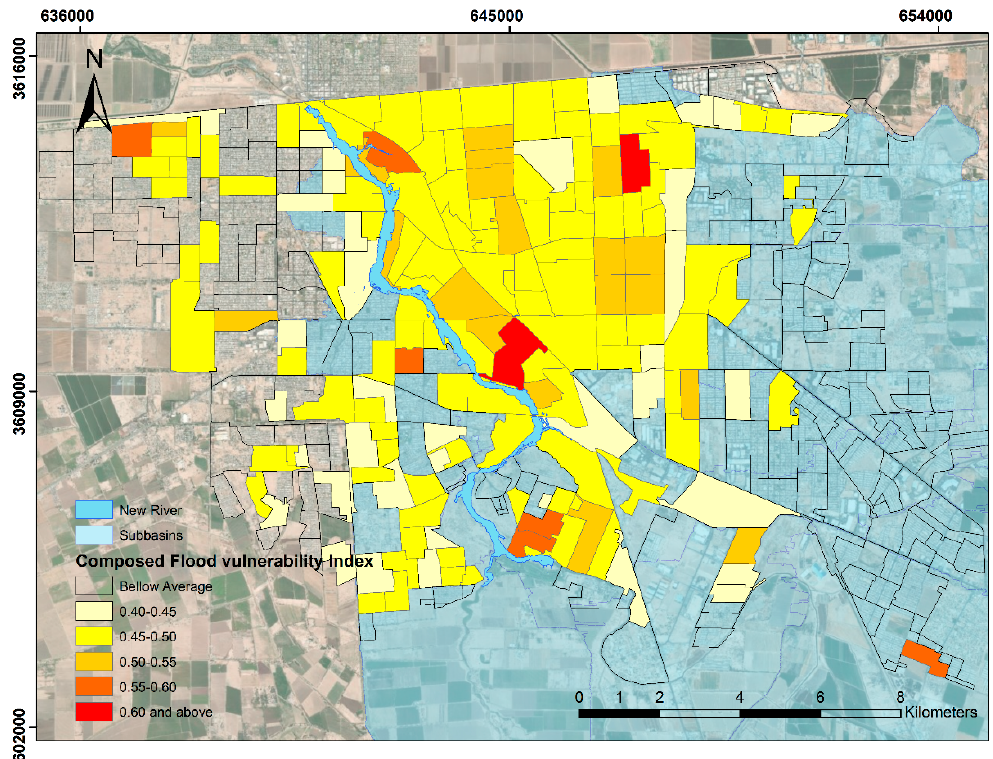
Figure 11. Assessment of AGEB units that showed an anomaly of above the mean vulnerability values.